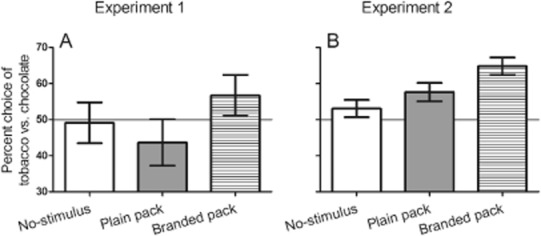
The vertical axis shows the mean percentage choice of the tobacco- versus chocolate-seeking response [± standard error of the mean (SEM)] during the Pavlovian to instrumental transfer (PIT) test (50% = equal choice or indifference). The horizontal axis shows the stimulus that was presented on the screen before a response choice was made: either no-stimulus, an image of a plain pack (Fig. 1a) or a branded pack (Fig. 1b). In both experiments, the branded pack stimulus primed tobacco-seeking more than the no-stimulus and plain pack conditions, and the latter two conditions did not differ